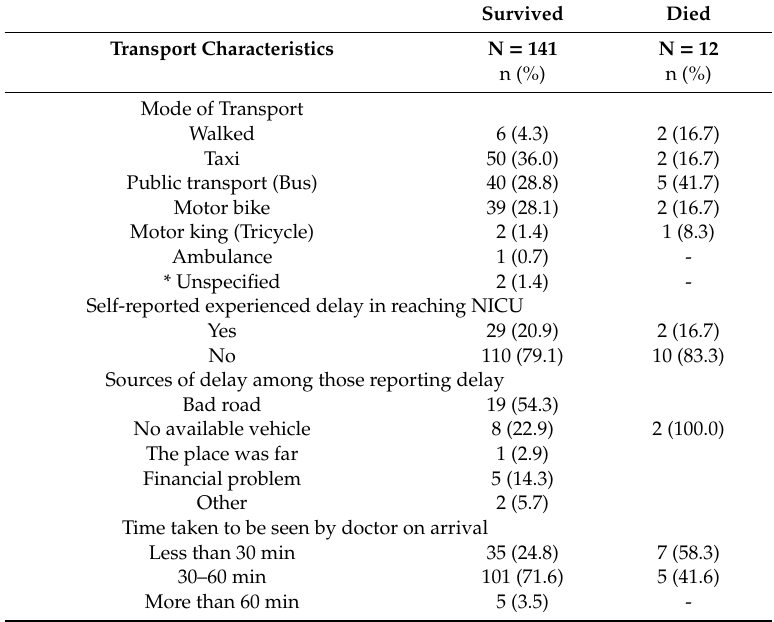
Table 2. Mode of transport to place of referral and sources of delays of outborn neonates during process of referral to UWRH and